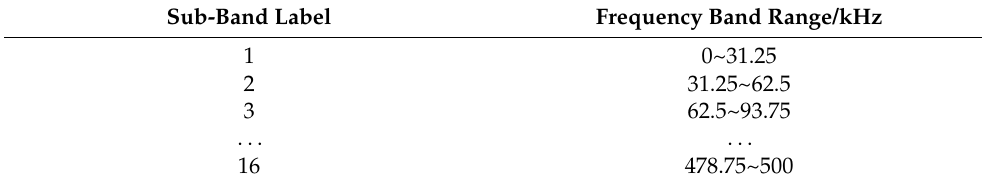
Table 2. Corresponding labels to band